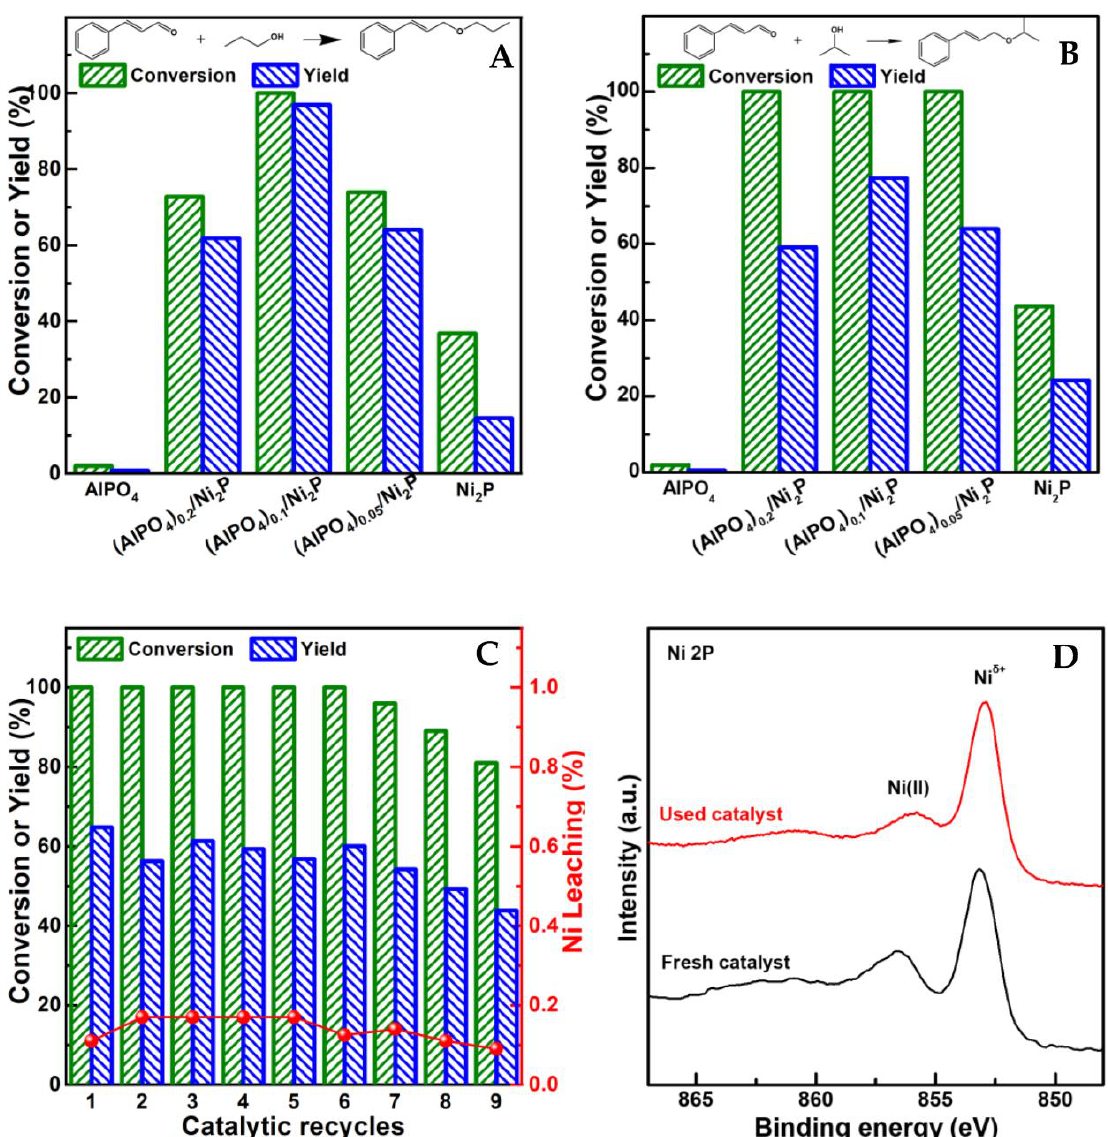
Figure 4. Typical catalytic performance of prepared catalysts. ( A , B ) Comparison of conversion of cinnamaldehyde (CA) and yield of unsaturated ether for hydrogenation transformation of CA in propyl alcohol among catalysts. ( C ) Catalytic performance variations of reused (AlPO 4 ) 0.05 /Ni 2 P for hydrogenation transformation of CA in isopropyl alcohol in catalytic recycles. ( D ) Comparison of surface properties with Ni 2p XPS spectra between fresh and cycle-used (AlPO 4 ) 0.05 /Ni 2 P. Reaction conditions: CA (1 mmol), catalyst (50 mg), dodecane (100 μL), reaction solvent (( A ) n-propyl alcohol, ( B ) isopropyl alcohol, 15 mL), 0.1 MPa H 2 , 393 K, reaction period (( A ) 2 h, ( B ) 4 h).